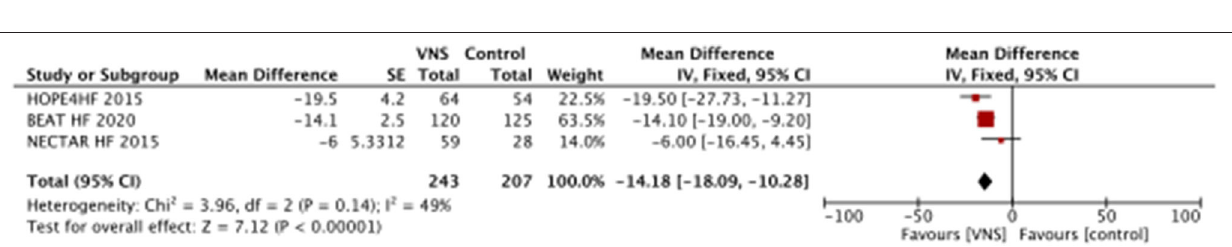
FIGURE 4 | Improvement of quality of life during follow-up between VNS and control groups for management of chronic heart failure with reduced ejection fraction. VNS, vagus nerve